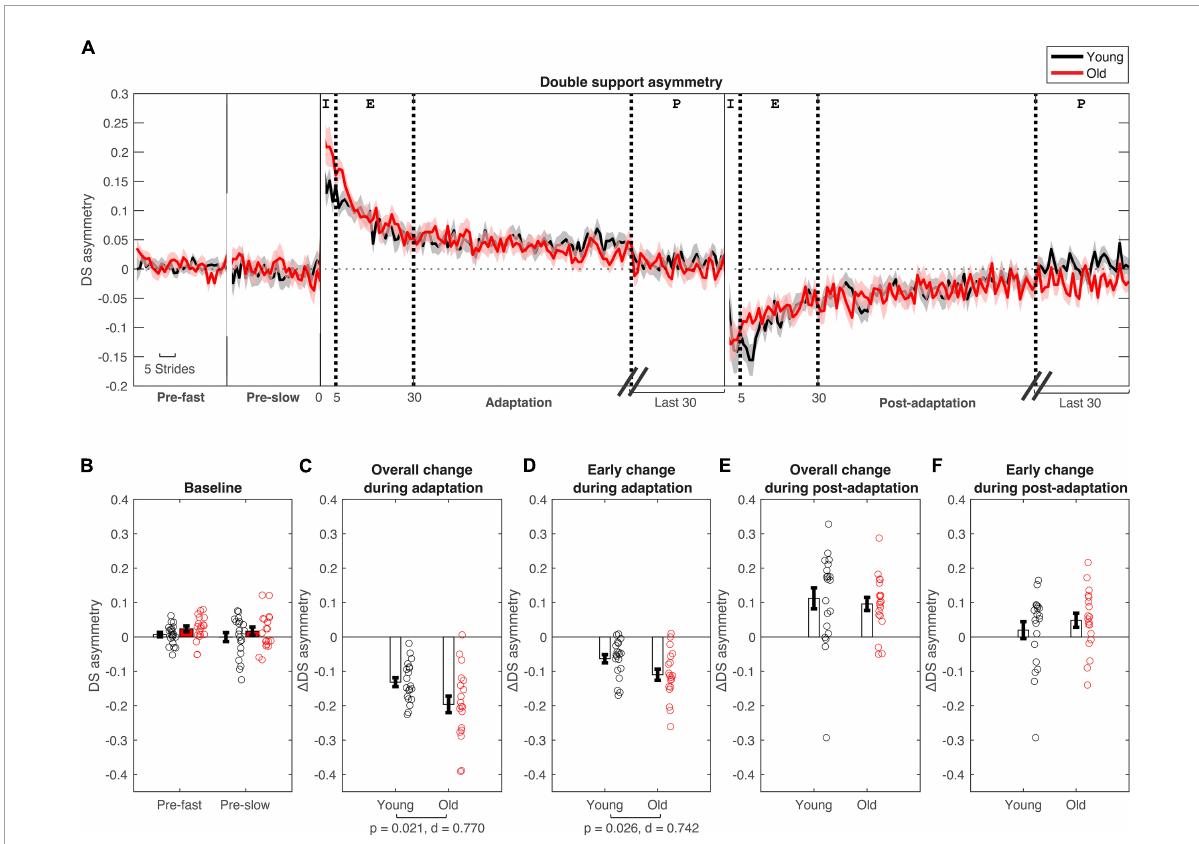
FIGURE3 Double support asymmetry changes during split-belt adaptation. (A) Stride-by stride changes in double support asymmetry plotted for young (in black) and older adults (in red). (B–F) Age group means and standard error bars for (B) baseline-fast and pre-slow conditions, (C) Overall change during adaptation ( (cid:49) plateau–initial), (D) early change during adaptation ( (cid:49) early–initial), (E) Overall change during post-adaptation ( (cid:49) plateau–initial), (F) early change during post-adaptation ( (cid:49) early–initial). See Figure 2 caption for description of epochs.